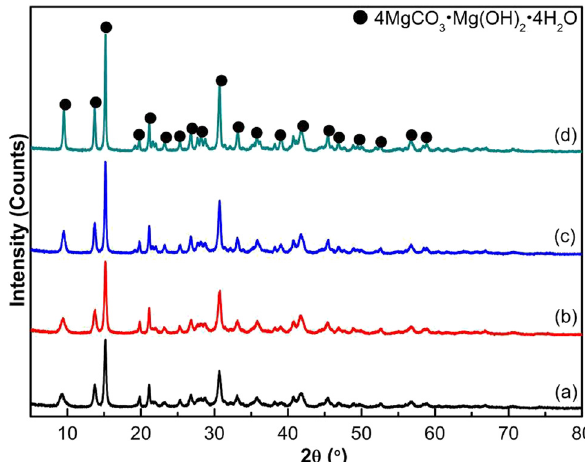
Figure 9: XRD patterns for the carbonation products from di ff erent aging times: ( a ) 1 h, ( b ) 4 h, ( c ) 8 h, and ( d ) 12 h.